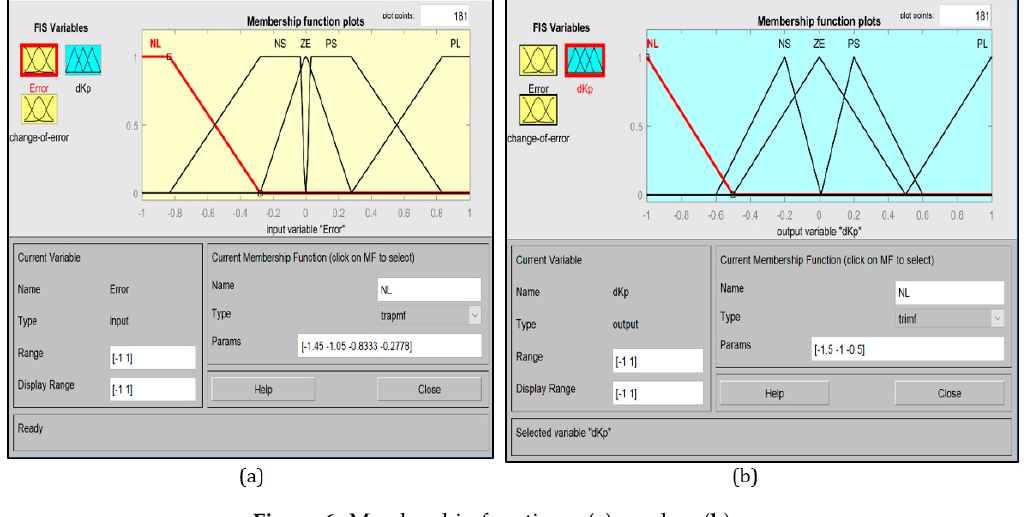
Figure 6. Membership functions. ( a ) e θ , de θ , ( b ) ω C .